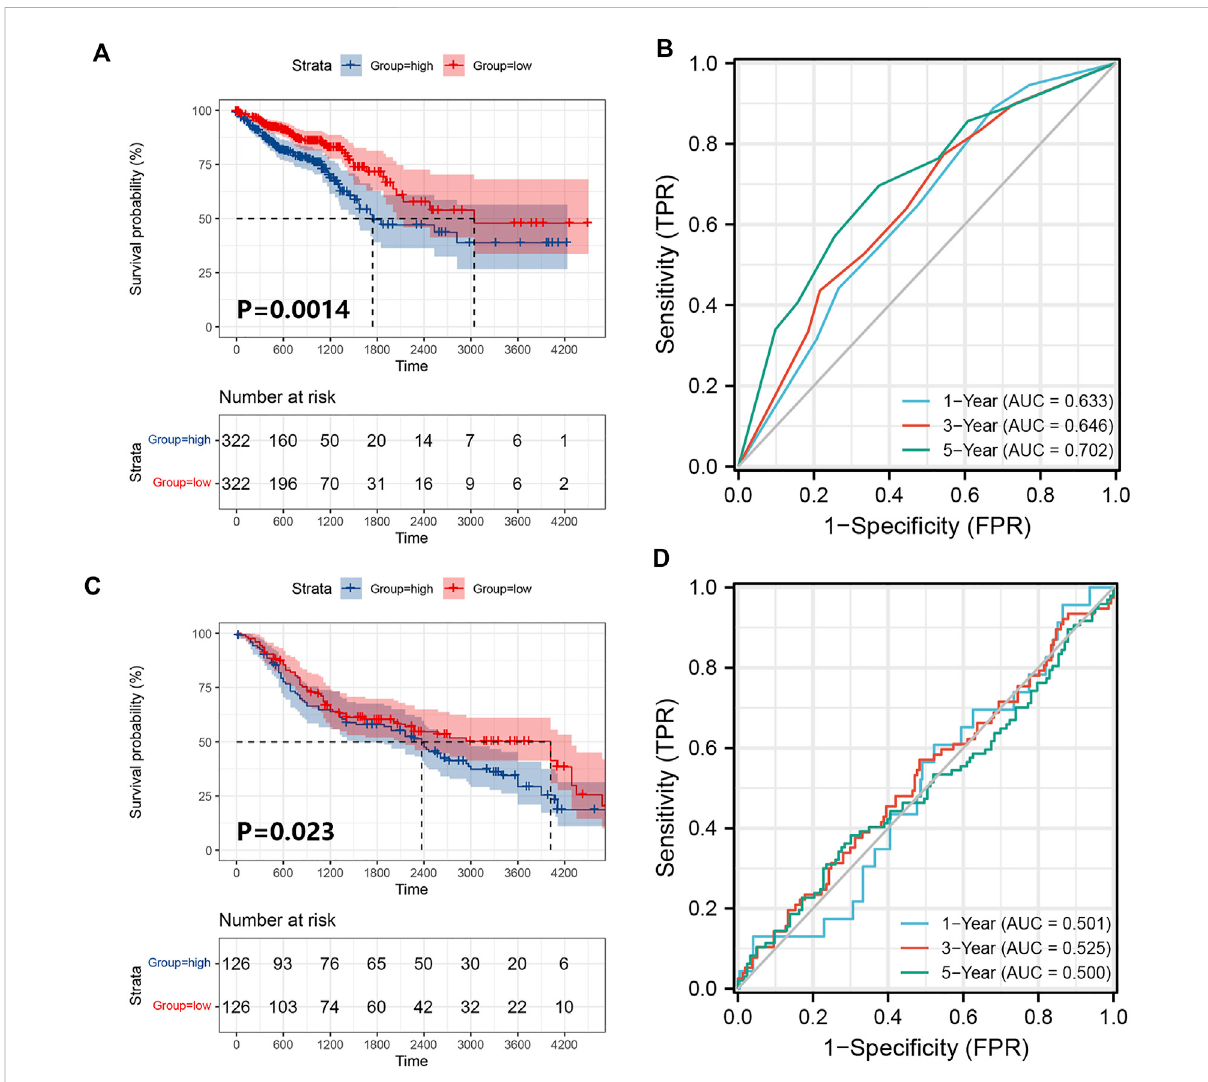
FIGURE 4 Establishment and veri fi cation of the prognostic model. (A) A prognostic model for patients with CRC based on the risk coef fi cients of ferroptosis-related genes ATG7, MAPK9 and MMD in TCGA-COADREAD. (B) The ROC curve of the three ferroptosis-related genes with the AUC in TCGA-COADREAD. (C) A prognostic model was established from three ferroptosis-related genes in the GEO: GSE41258. (D) The ROC curve of the three ferroptosis-related genes with the AUC in GEO: